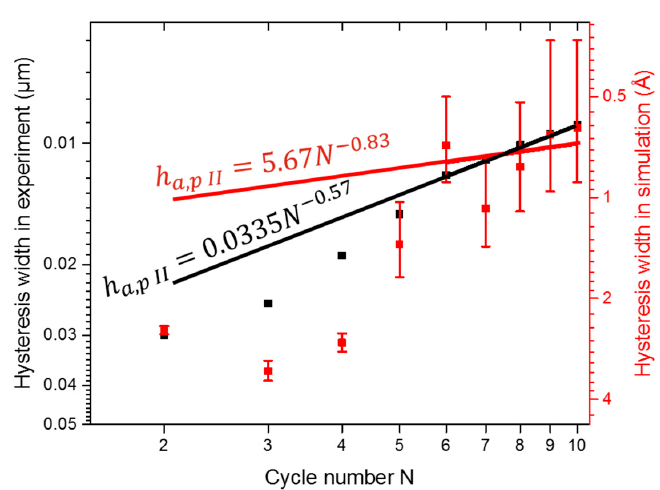
Figure 16. Comparison of experimental and simulated hysteresis widths as a function of cycle number N .